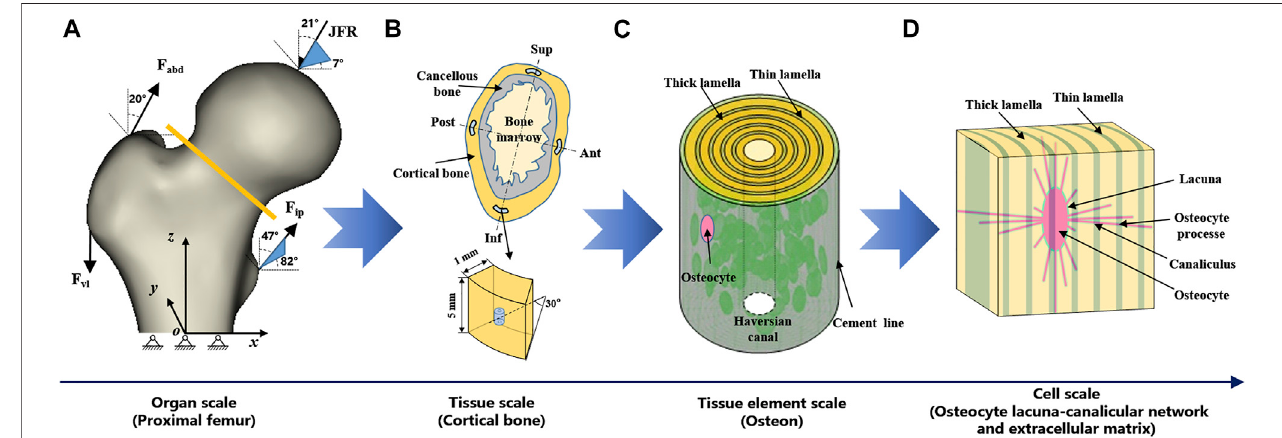
FIGURE1| Multiscale FEmodelsofproximalfemur. (A) organ scale(proximal femur), (B) tissue scale (cortical bone), (C) tissueelement scale(osteon),and (D) cell scale (OLCEM). Superior (Sup), Inferior (Inf), Anterior (Ant), Posterior (Post).